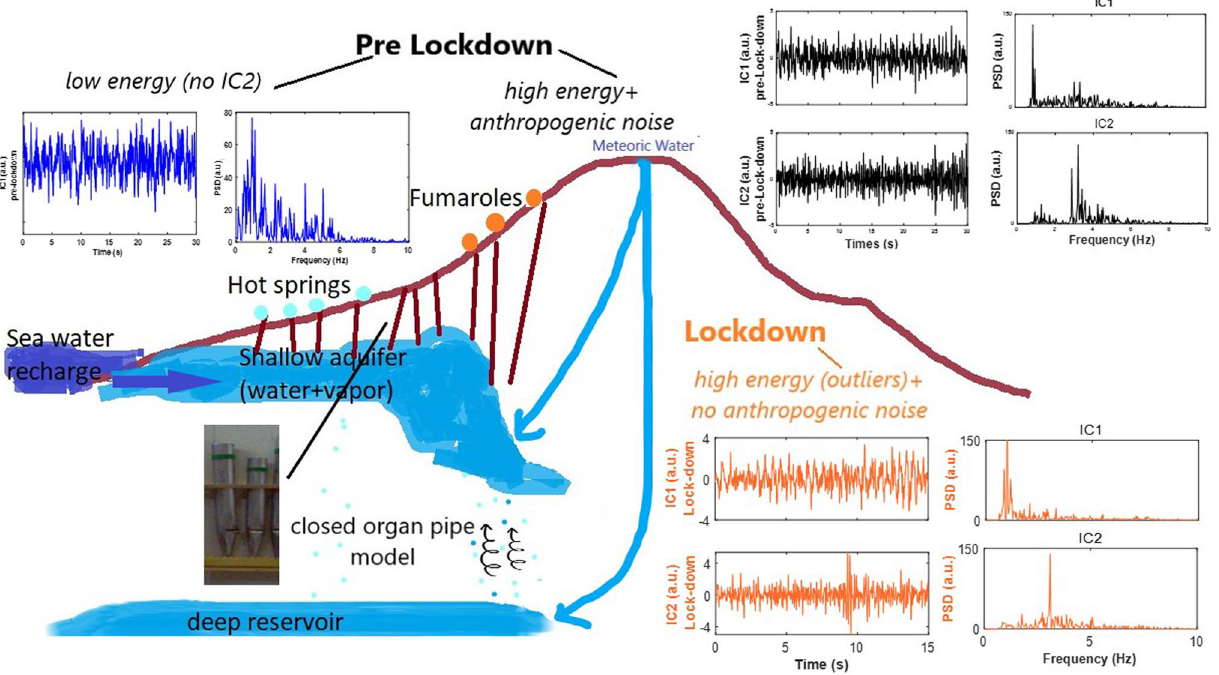
Figure 6. Sketch of the hydrothermal system at Ischia: functioning of the organ-pipe like model providing the whisper. The picture of the closed pipes is taken from the laboratory of Acoustics (Salerno University) and is representative of the behaviour of the system. The helicoidal arrows indicate fluid flow from the deep reservoir to the shallow aquifer, which in turn is mainly fed by meteoric and sea water; the red lines are representative of the faults, feeding fumaroles and hot springs. The panels show waveforms and spectra of the extracted components in pre-lockdown (blue and black lines), and lockdown (orange